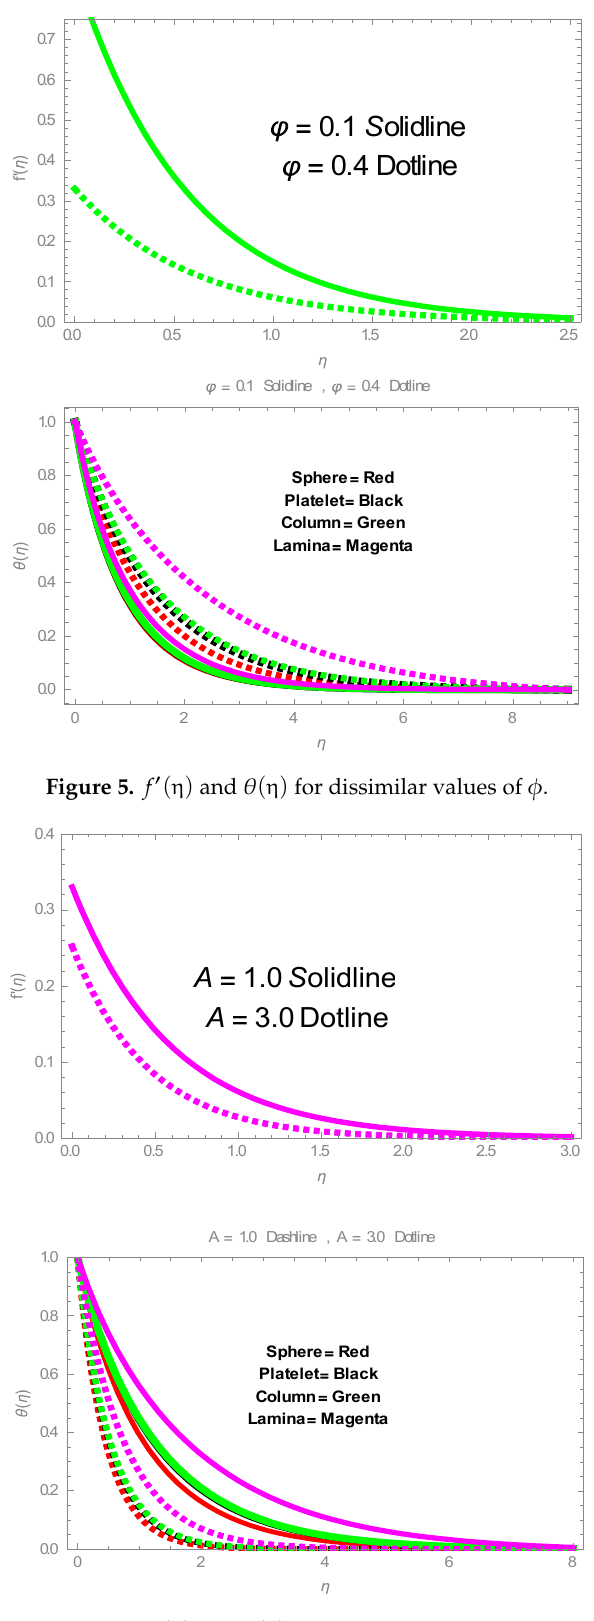
Figure 6. f (cid:48) ( η ) and θ ( η ) for dissimilar values of